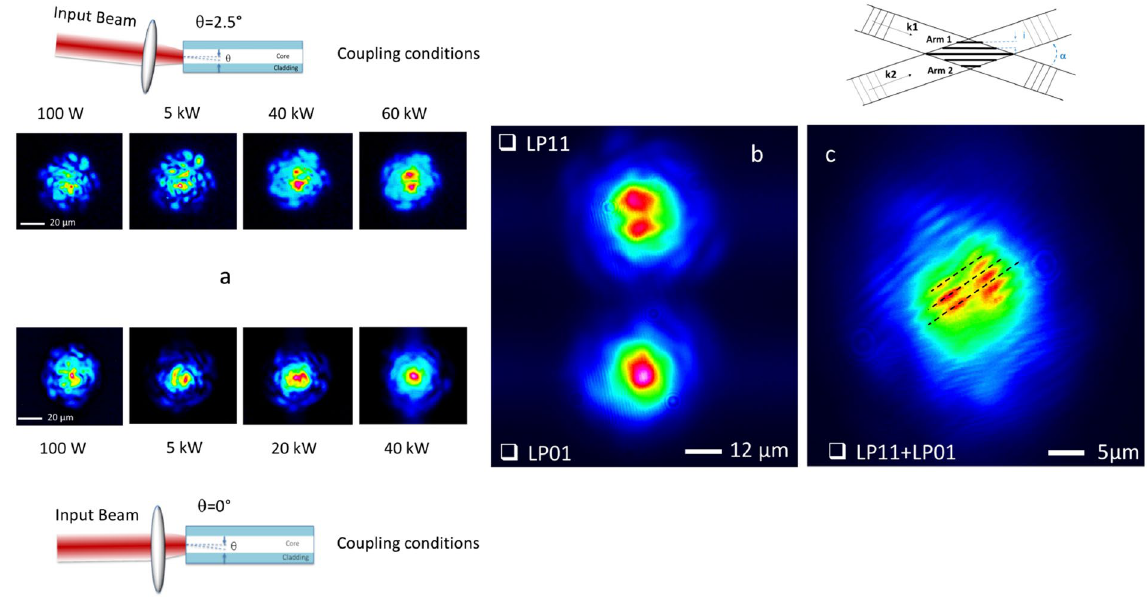
self-cleaning of LP11 and LP01 modes, respectively. ( b ) Output beams self-cleaned on the LP11 transverse mode (top) and on the LP01 mode (bottom) prior to their spatial overlap. ( c ) Spatial interference pattern produced by two self-cleaned output beams, spatially superimposed with a 4° tilt angle (dashed lines are shown as a visual guide to illustrate phase opposition between fringes from different